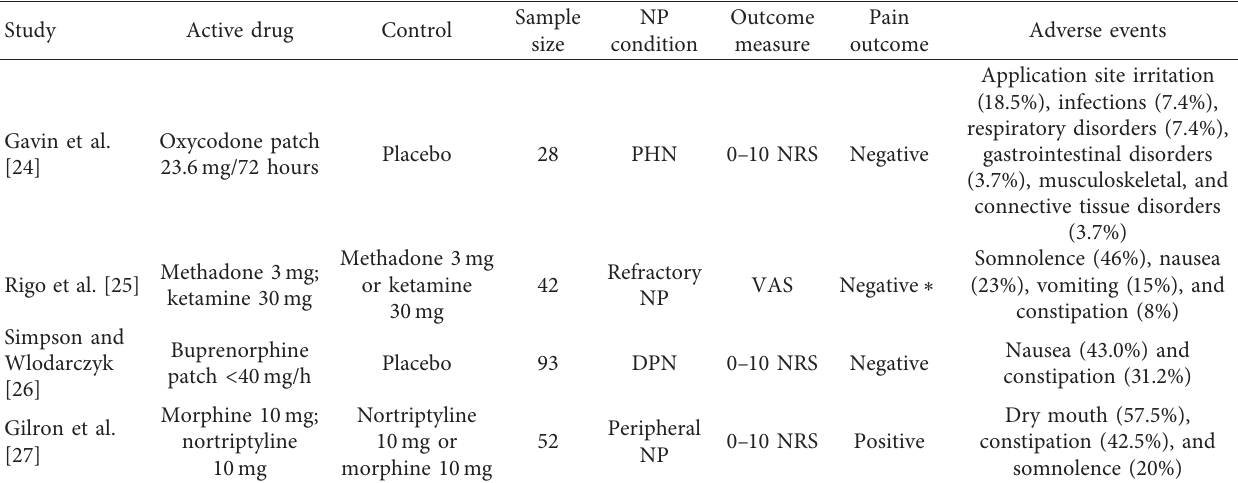
Table 4: Randomized, double-blind, controlled trials testing the effect of